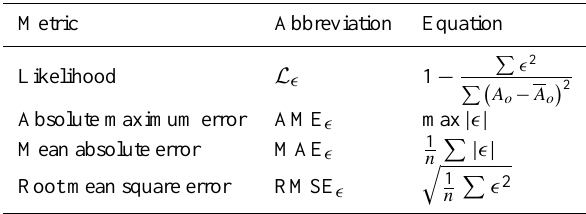
Table 3. Definition of water balance model parameters. Table 4. Evaluation metrics used for the calibration or validation steps of the water balance model. (cid:15) is defined in either Eqs. (14) or (15). A o : flood extent measured from the MODIS imagery; A o : mean flood extent from MODIS imagery; n : number of concurrent TIM and MODIS